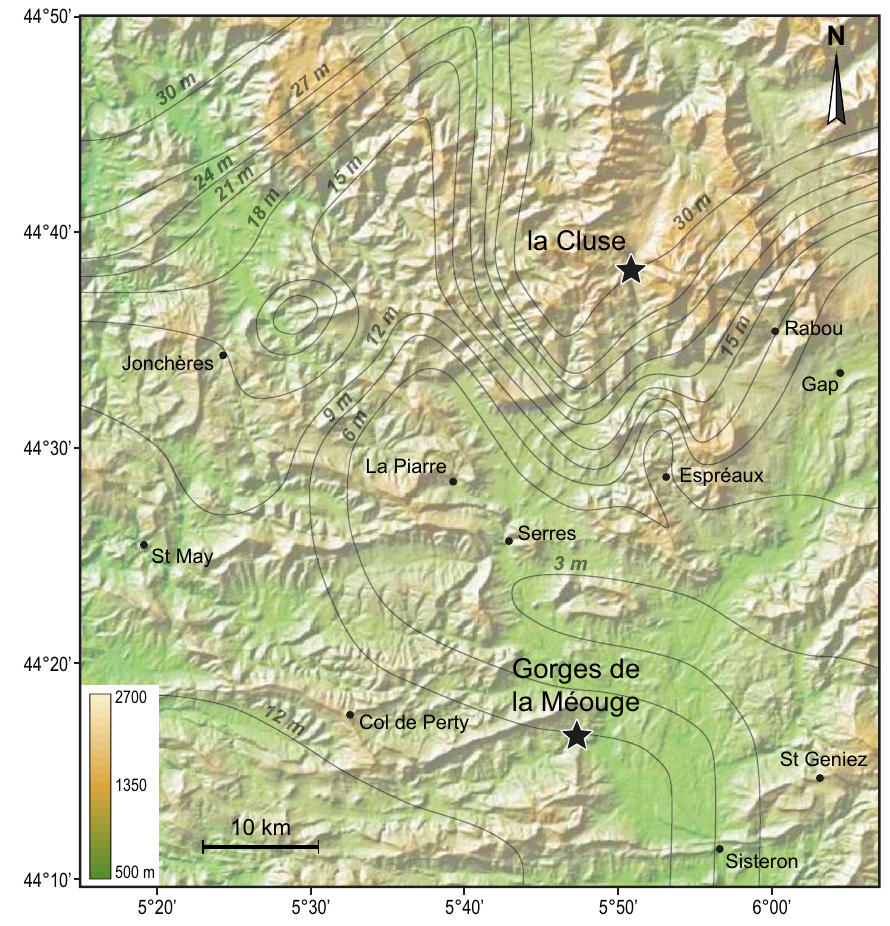
Figure 2. Topographic map of the studied La Cluse site, and other sites recording the Lothari ammonite Subzone (Early Kimmeridgian) in southeastern France, and isopachs of the Lothari ammonite Subzone (modified from Pederneiras 24 ). This figure was generated by Adobe Illustrator CS6 software (https:// helpx. adobe. com/ fr/ illus trator/ using/ links- info. html). Stratigraphic correlation of the La Cluse section with its time- equivalent La Méouge (indicated by stars) is shown in the Supplementary Figure